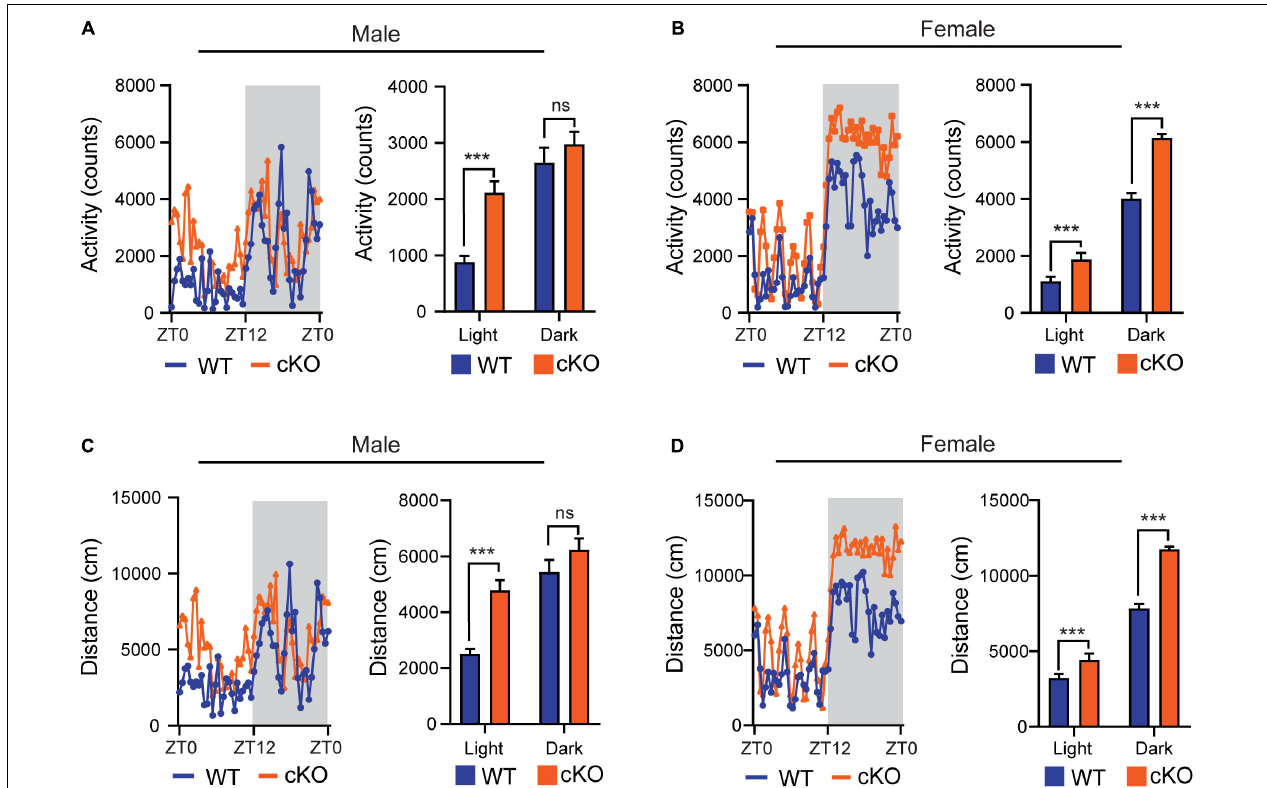
FIGURE 1 | Loss of Ash1L in the mouse brain causes locomotor hyperactivity. (A,B) Plots showing total times (counts) that male (A) and female (B) wild-type and Ash1l -Nes-cKO mice passing through an infrared sensor in a 12-h light-on cycle (ZT0–ZT12, Zeitgeber Time) and a 12-h light-off cycle (ZT12–ZT0, Zeitgeber Time). n = 4 males and four females per genotype. P -values calculated using two-way ANOVA tests. Error bars in graphs represent mean ± SEM. *** p < 0.001; ns, not significant. (C,D) Plots showing the distances that male (C) and female (D) wild-type and Ash1l -Nes-cKO mice run in the 12-h light-on cycle (ZT0 – ZT12, Zeitgeber Time) and the 12-h light-off cycle. n = 4 males and four females per genotype. P -values calculated using two-way ANOVA tests. Error bars in graphs represent mean ± SEM. *** p < 0.001; ns, not significant.